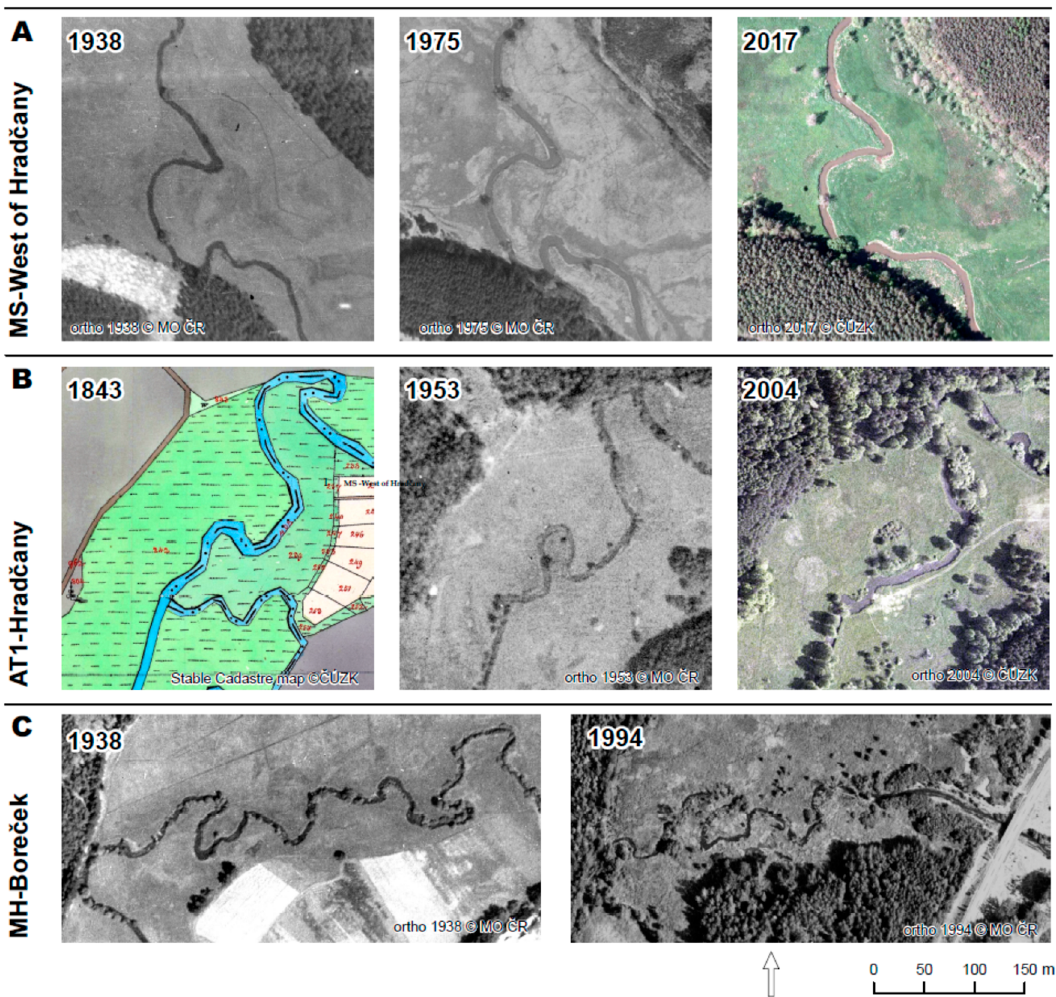
Figure 2. Stable Cadastre maps and archive orthophotos of the study areas.